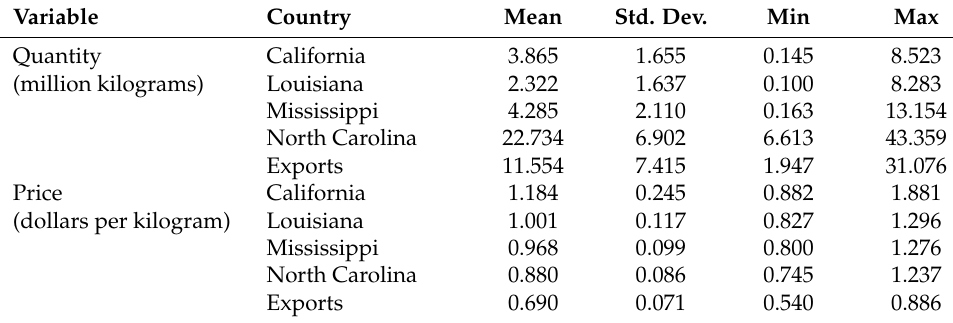
Table 1. Descriptive statistics of the monthly data by source.